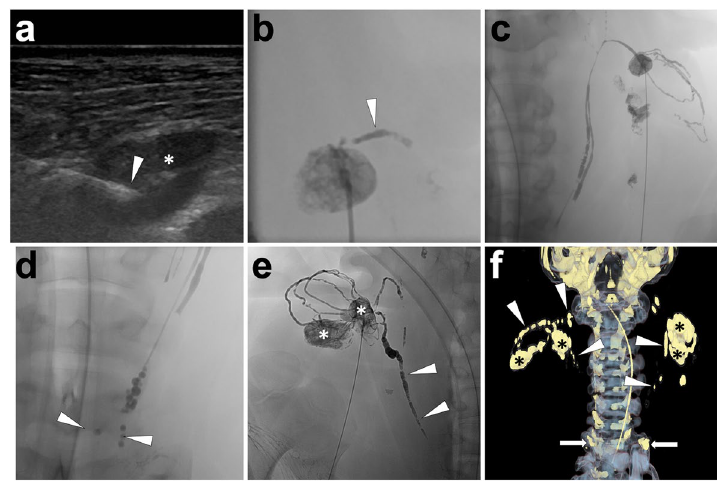
Fig. 4 Illustration of lipiodol-based cervical INL in a pig model. In this case, lipiodol-based cervical INL was introduced. Under ultrasonography guidance, the tip of the needle ( white arrowhead ) was advanced until reaching the center of the target lymph node ( * ) ( A ). An efferent lymphatic vessel ( white arrowhead ) at the left neck was opacified after a small amount of lipiodol injection ( B ); then, continue the lipiodol injection. Over time, lipiodol gradually shifted towards the left jugular vein angle over time ( C ). The lipiodol injection ceased when oil-dropped lipiodol entered the left brachiocephalic vein ( white arrowheads ; D ). As the same, the lymph nodes ( * ), efferent lymphatic vessels, and right lymphatic duct ( white arrowheads ) at the right side of the neck were gradually opacified after the lipiodol injection ( E ). After INL, remove the needles and carry out the volume rendering reconstruction of post-lymphangiography CT to demonstrate the three-dimensional lymphatic structure, such as lymph nodes ( * ), lymphatic vessels ( white arrowheads ), and bilateral confluences of jugular venous angles ( white arrows ; F ). Images were from Pig No. 7 . Abbreviation: INL, intranodal lymphangiography; CT, computed tomography